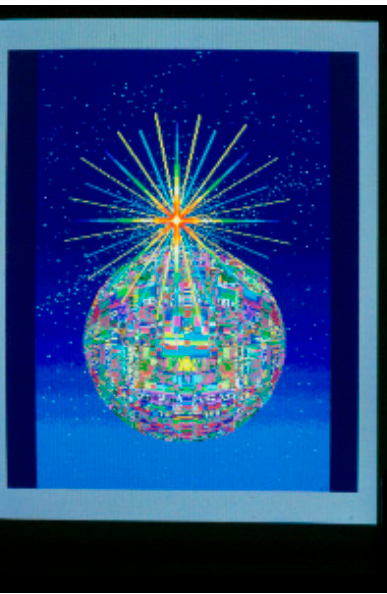
Figure 5. Unnamed image from Ostoja’s slide collection. It seems to correspond to the disk label “Homage to Albers” (seen in a later Figure). Published with permission. Image courtesy of the State Library of South Australia. SLSA: PRG919/22/69.